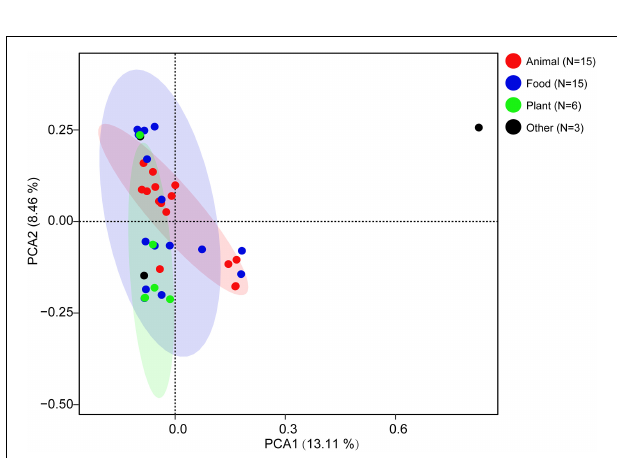
FIGURE 5 | Gene distribution of 39 W. confusa strains based on the gene presence–absence matrix generated from the Bacterial Pan Genome Analysis (BPGA).